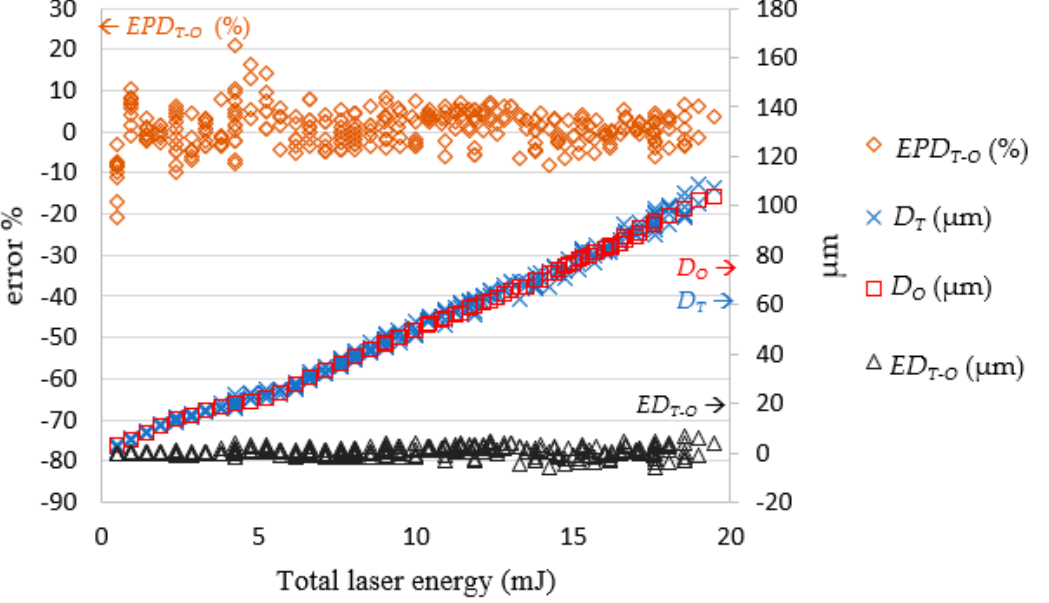
Figure 18. Comparison of D T and D O . Note: ED T-O = D T − D O ; EPD T-O = ( D T − D O )/ D O (%).